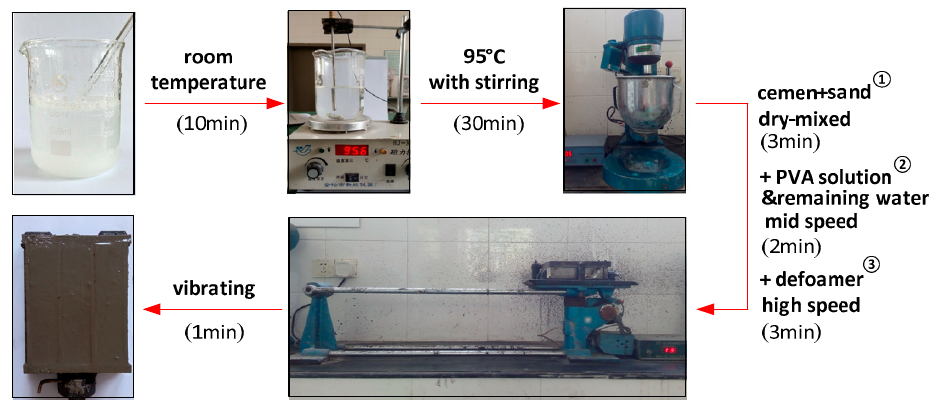
Figure 2. Illustration of the PVA modified cement mortar fabrication process.